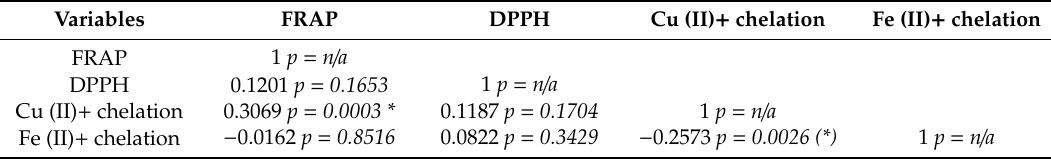
Table 2. Spearman’s correlation ( ρ ) of C. di ffi cile -infected fecal